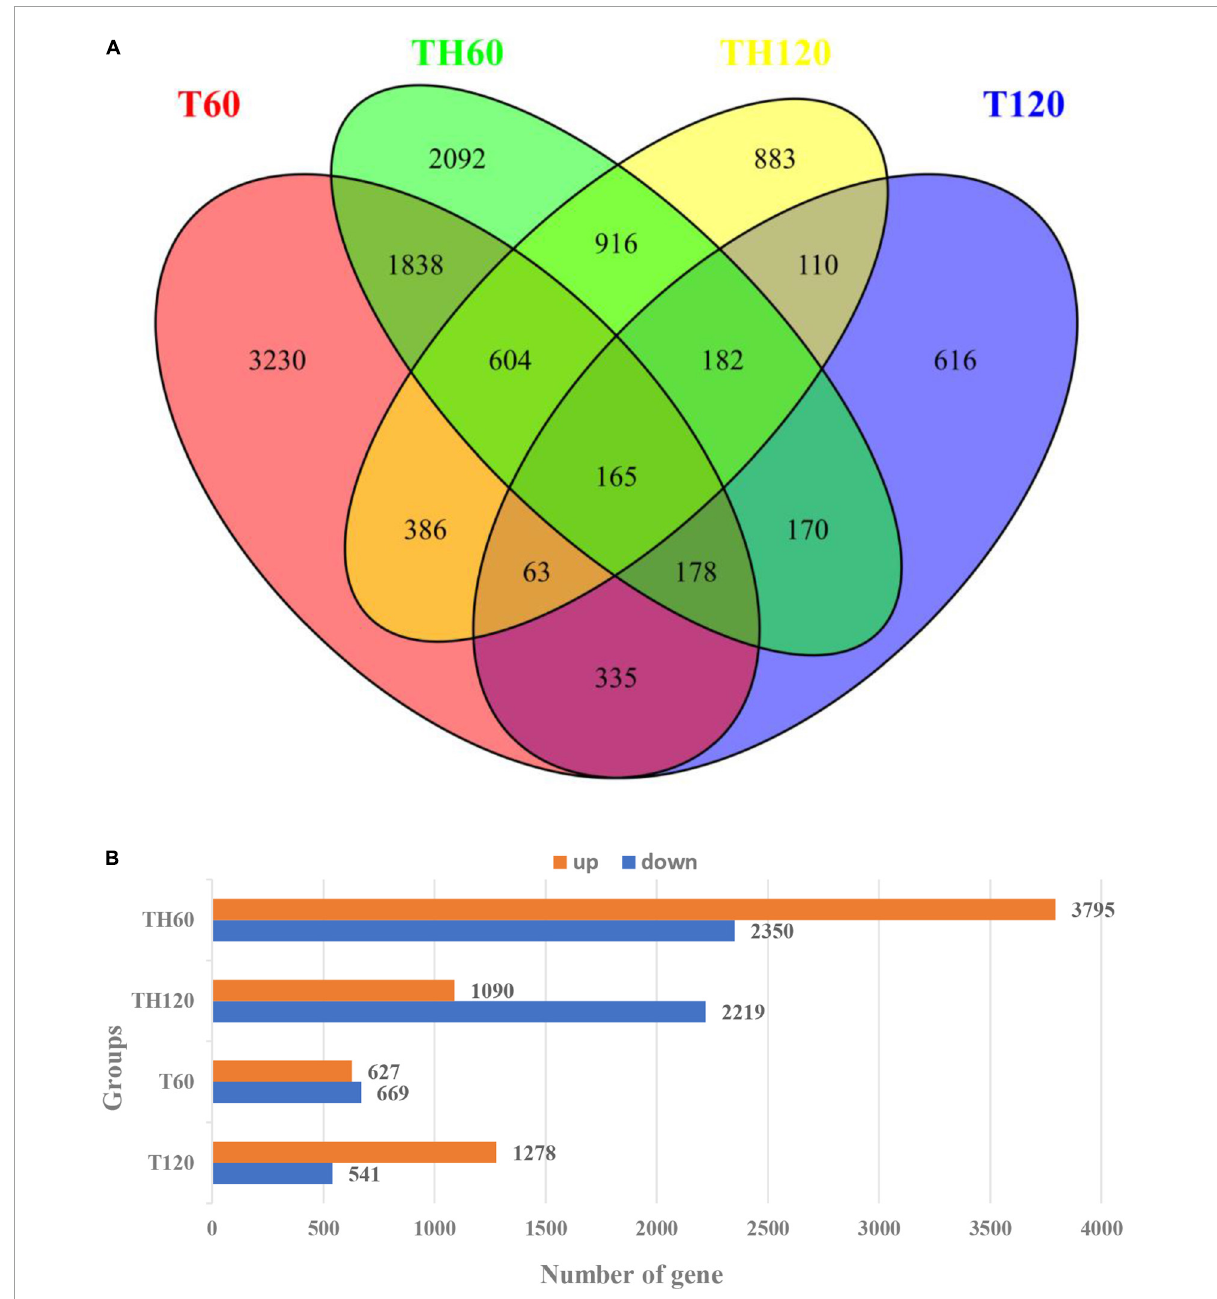
FIGURE2 All differentially expressed genes (DEGs) at 60 mM and 120 mM NaCl treatment. (A) The DEGs Venn diagram of HD961and 9311. (B) The up and downregulated DEGs of HD961 and